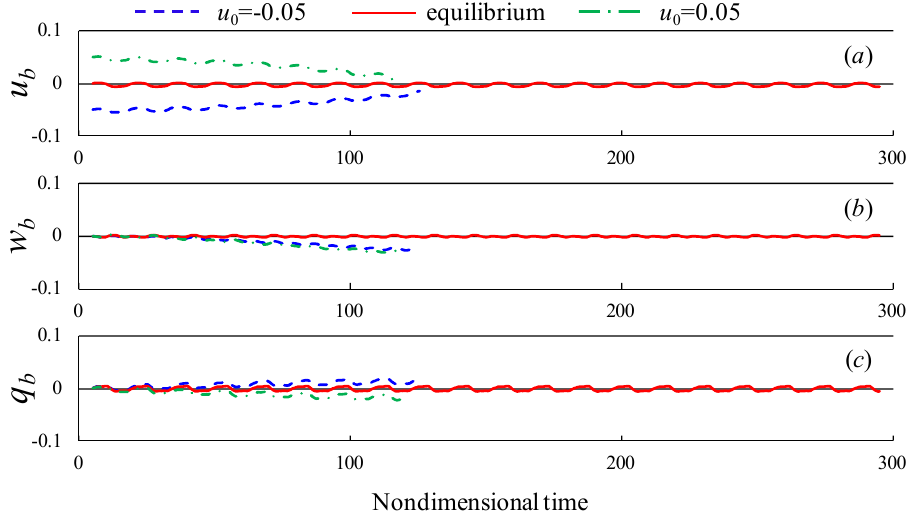
Figure 2. ( a-c ) Time variations of state variables ( u b , w b , q b ) under initial conditions of u 0 = -0.05 (dashed blue lines) and u 0 = 0.05 (dashed dotted green lines) with v 0 = w 0 = p 0 = q 0 = r 0 = 0 and t 0 =